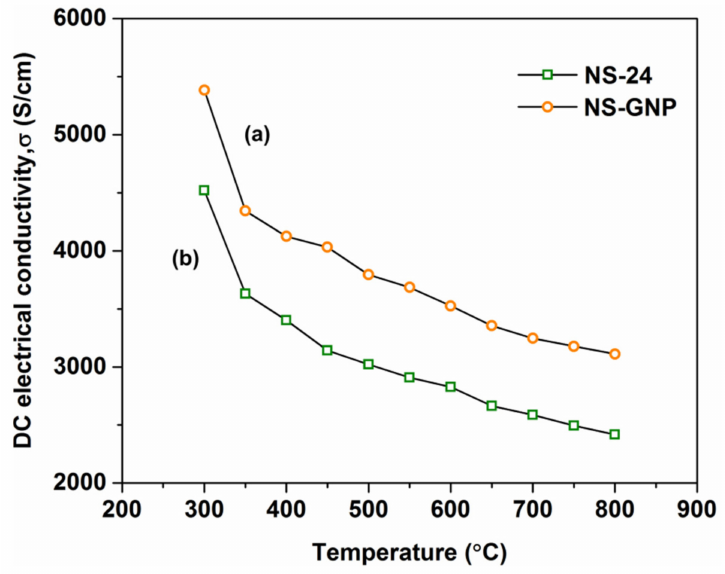
Figure 8. Electrical conductivities of ( a ) NS-GNP and ( b ) NS-24 cermet anode.